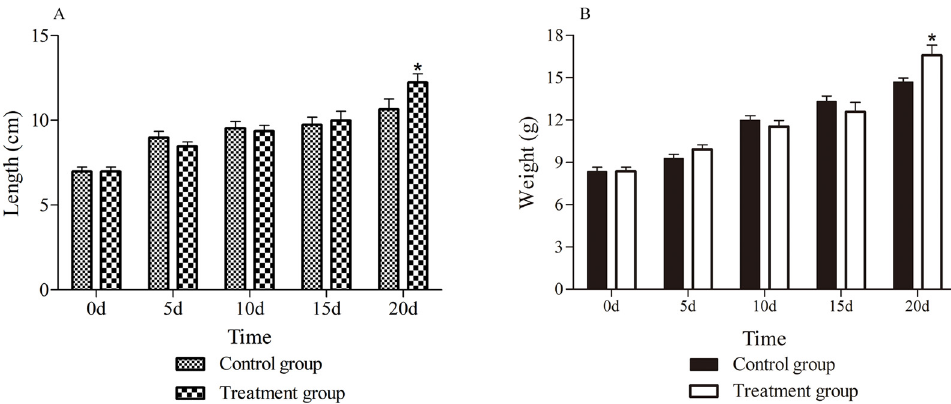
Figure 1. Length and weight of Pampus argenteus in the two groups. ( A ) The changes in body weight in the treatment group and control group after feeding for different times. ( B ) Body length changes of the treatment group and control group after feeding for different times. * indicates the difference between the two groups is significant ( p < 0.05). Table 1. Growth performance of silver pomfret fed diets supplemented with 2% Schizochytrium sp. for 20 days (treatment group) and without Schizochytrium sp. (Control group).